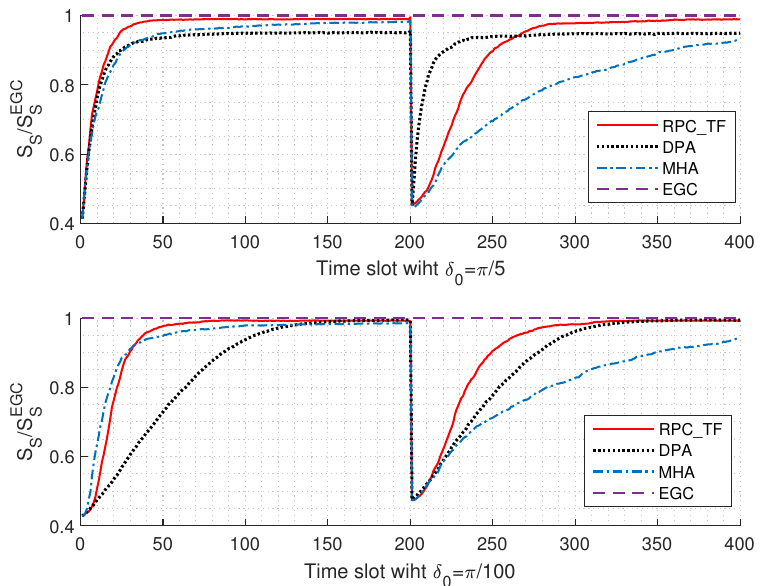
Figure 6. Comparison of the average convergence speeds of three algorithms for the situation in which a sudden change occurs at timeslot t = 200, where L = 4, γ = 0 dB, δ 0 =